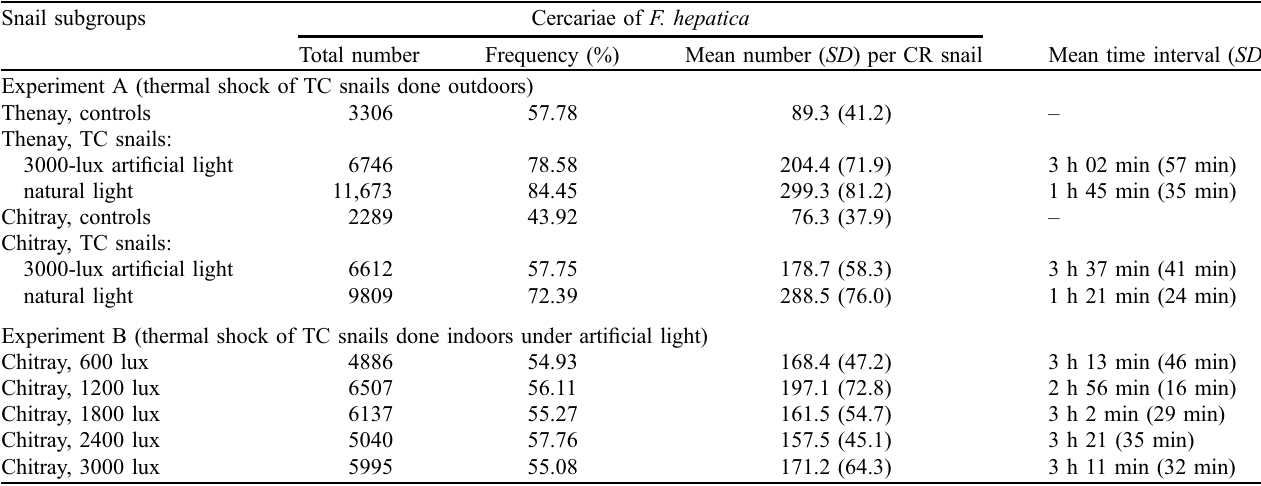
Table 2. Numbers of Fasciola hepatica cercariae counted during days of thermal shock for temperature-challenged (TC) snails and the corresponding days for controls, with indication of time intervals between the end of thermal shock and the beginning of cercarial emergence. The number of cercariae-releasing (CR) snails in each subgroup is given in Table